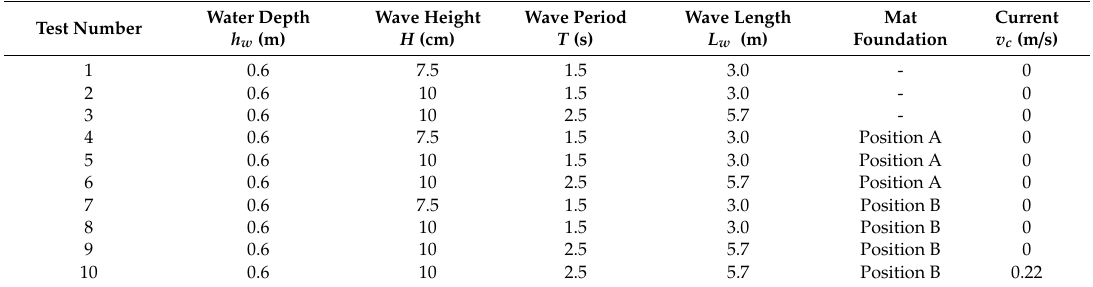
Table 3. Summary of experimental tests for wave, current, and mat foundation